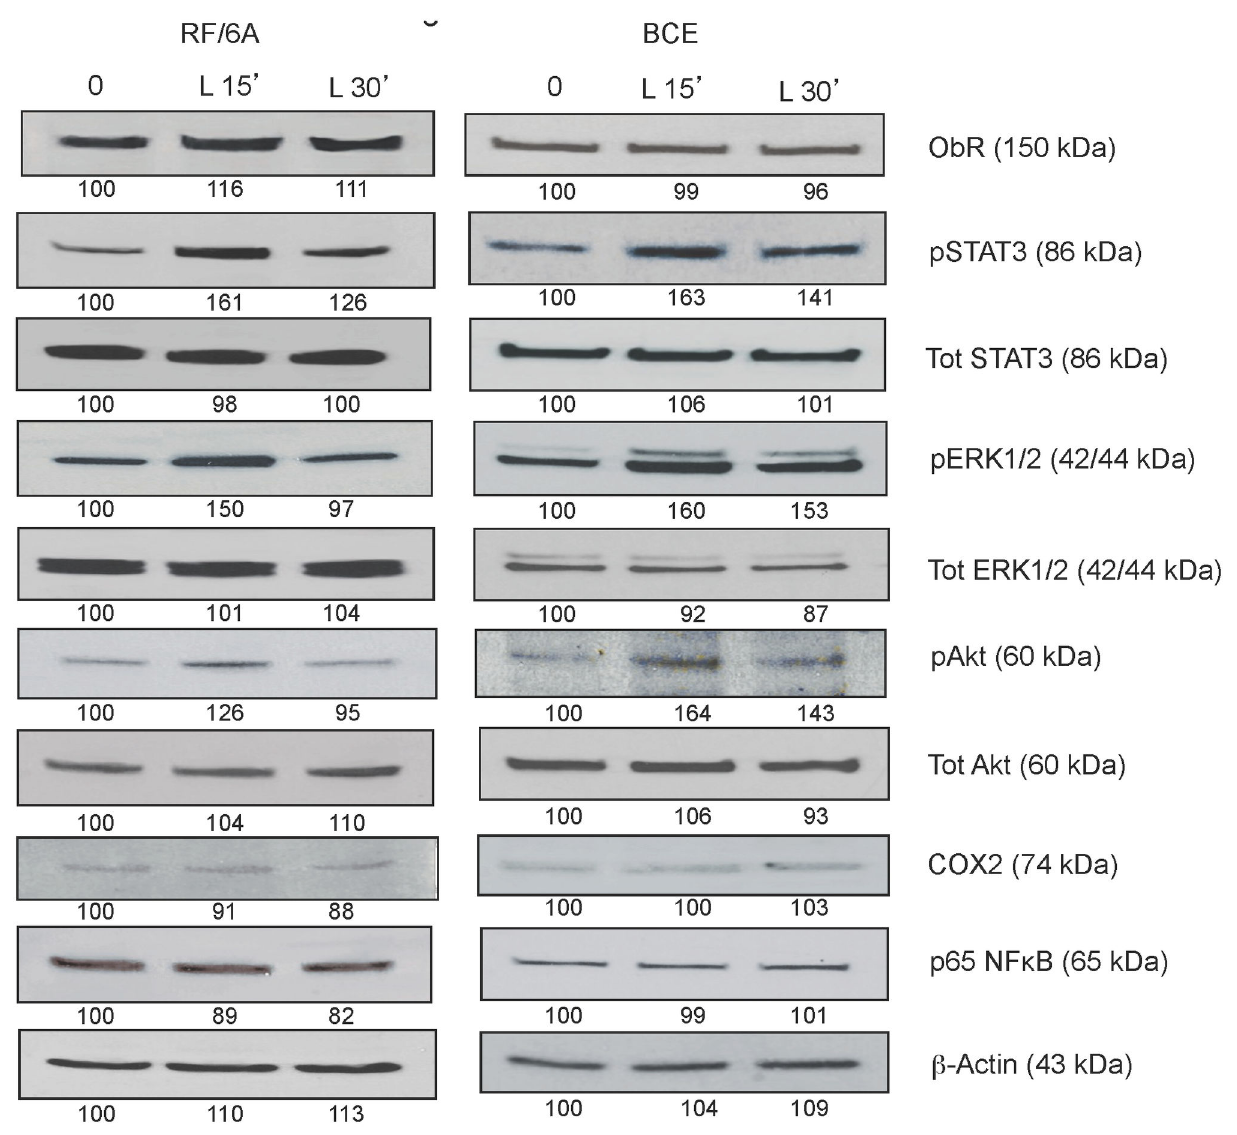
Figure 5. Leptin effects on intracellular signaling in RF/6A and BCE cells. RF/6A and BCE cells were stimulated with 250 ng/mL leptin (L) for 15 and 30 min and the expression of phosphorylated (p) and total (Tot) proteins was assessed by WB and quantified as described in Materials and Methods. The levels of β-actin were assessed as control of loading. The numbers under WB panels represent relative densitometry values (%) of phosphorylated and total proteins, with the value in SFM is taken as 100%. The representative blots of at least 3 experiments are shown.